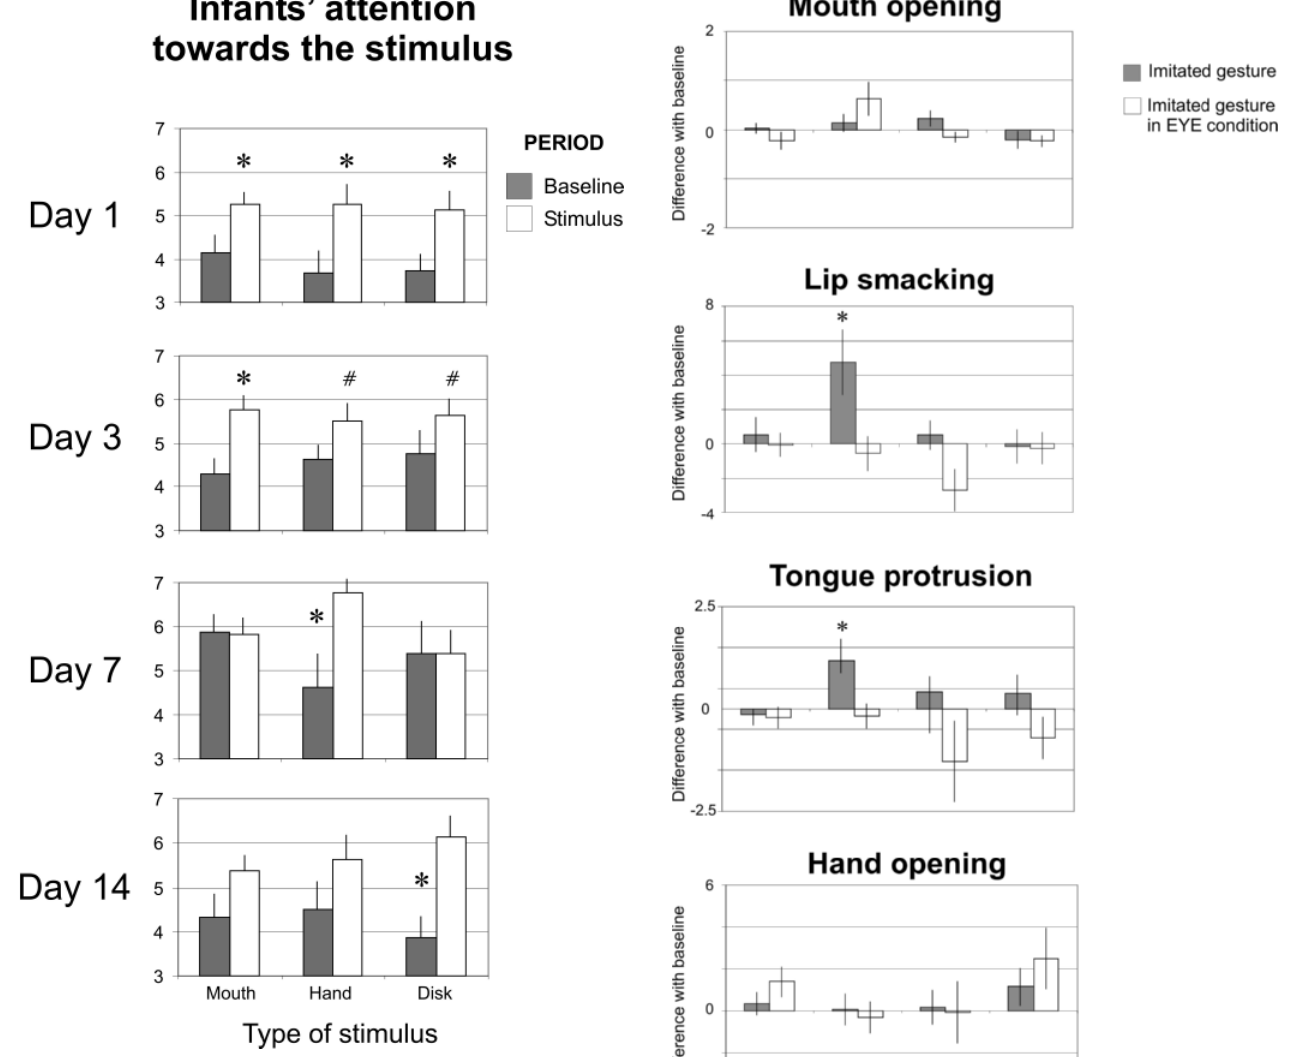
Figure 2. Frequencies of Looks That the Infants Oriented at the Stimulus during the Baseline and the Stimulus Period Asterisks (*) indicate a significant increase in number of looks (stimulus versus baseline) for a specific stimulus (at least p , 0.05). Pound symbols (#) indicate that this effect is close to statistical significance ( p , 0.07). Because data concerning looks at models’ LPS, MO, and TP were very similar, they were averaged and pooled. Frequencies are 6 standard error of the mean.